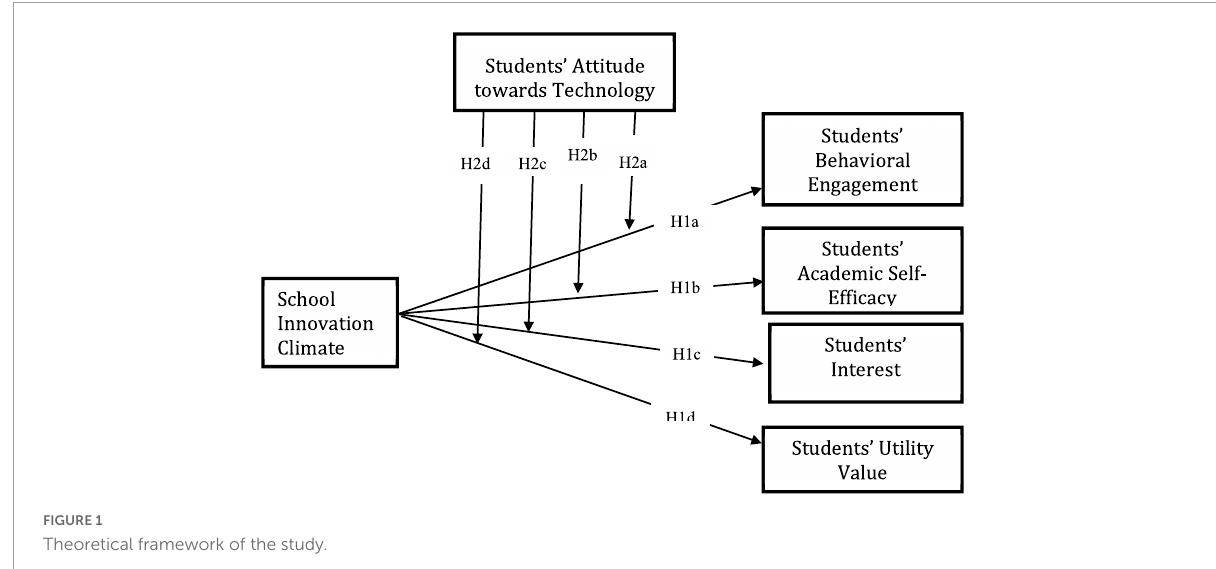
FIGURE1 Theoretical framework of the